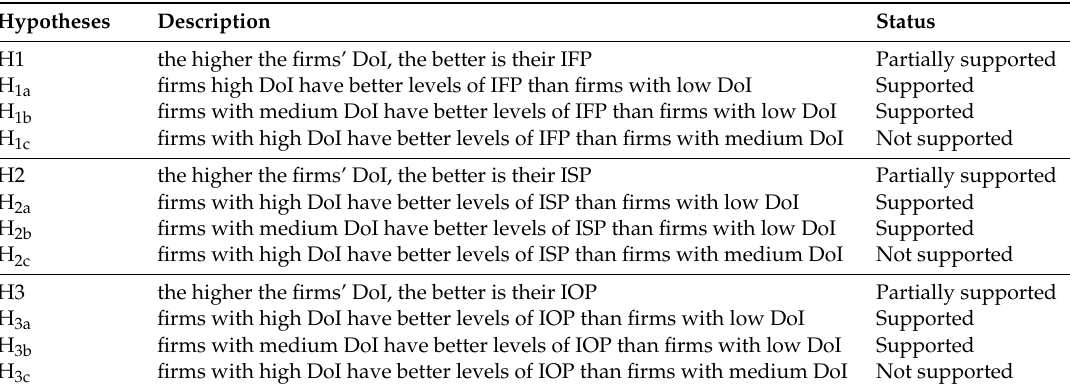
Table 5. Hypotheses summary